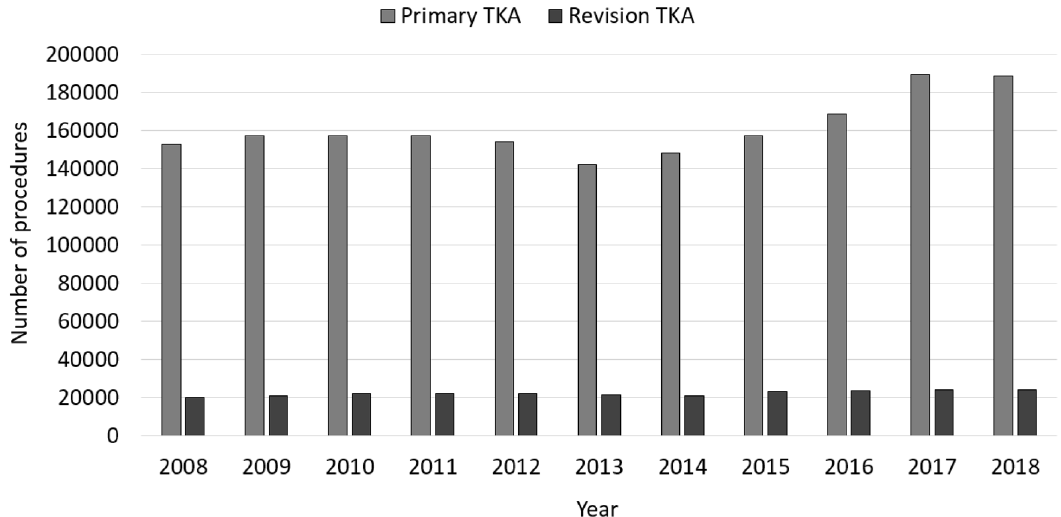
Figure 1. Performed revision knee arthroplasty procedures in comparison to performed primary knee arthroplasty procedures from 2008 through